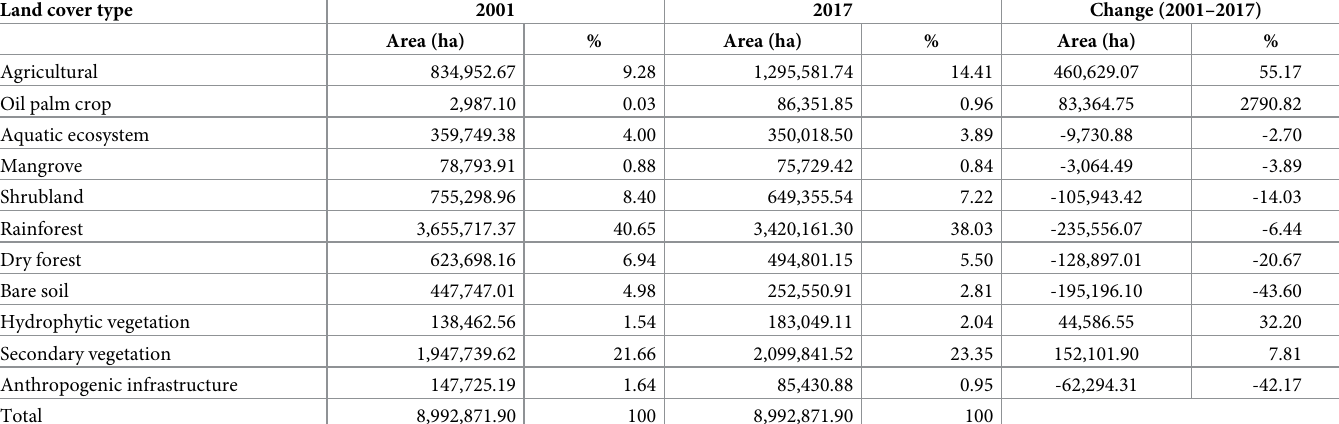
Table 3. Land use/land cover changes in the Usumacinta watershed during the period 2001–2017